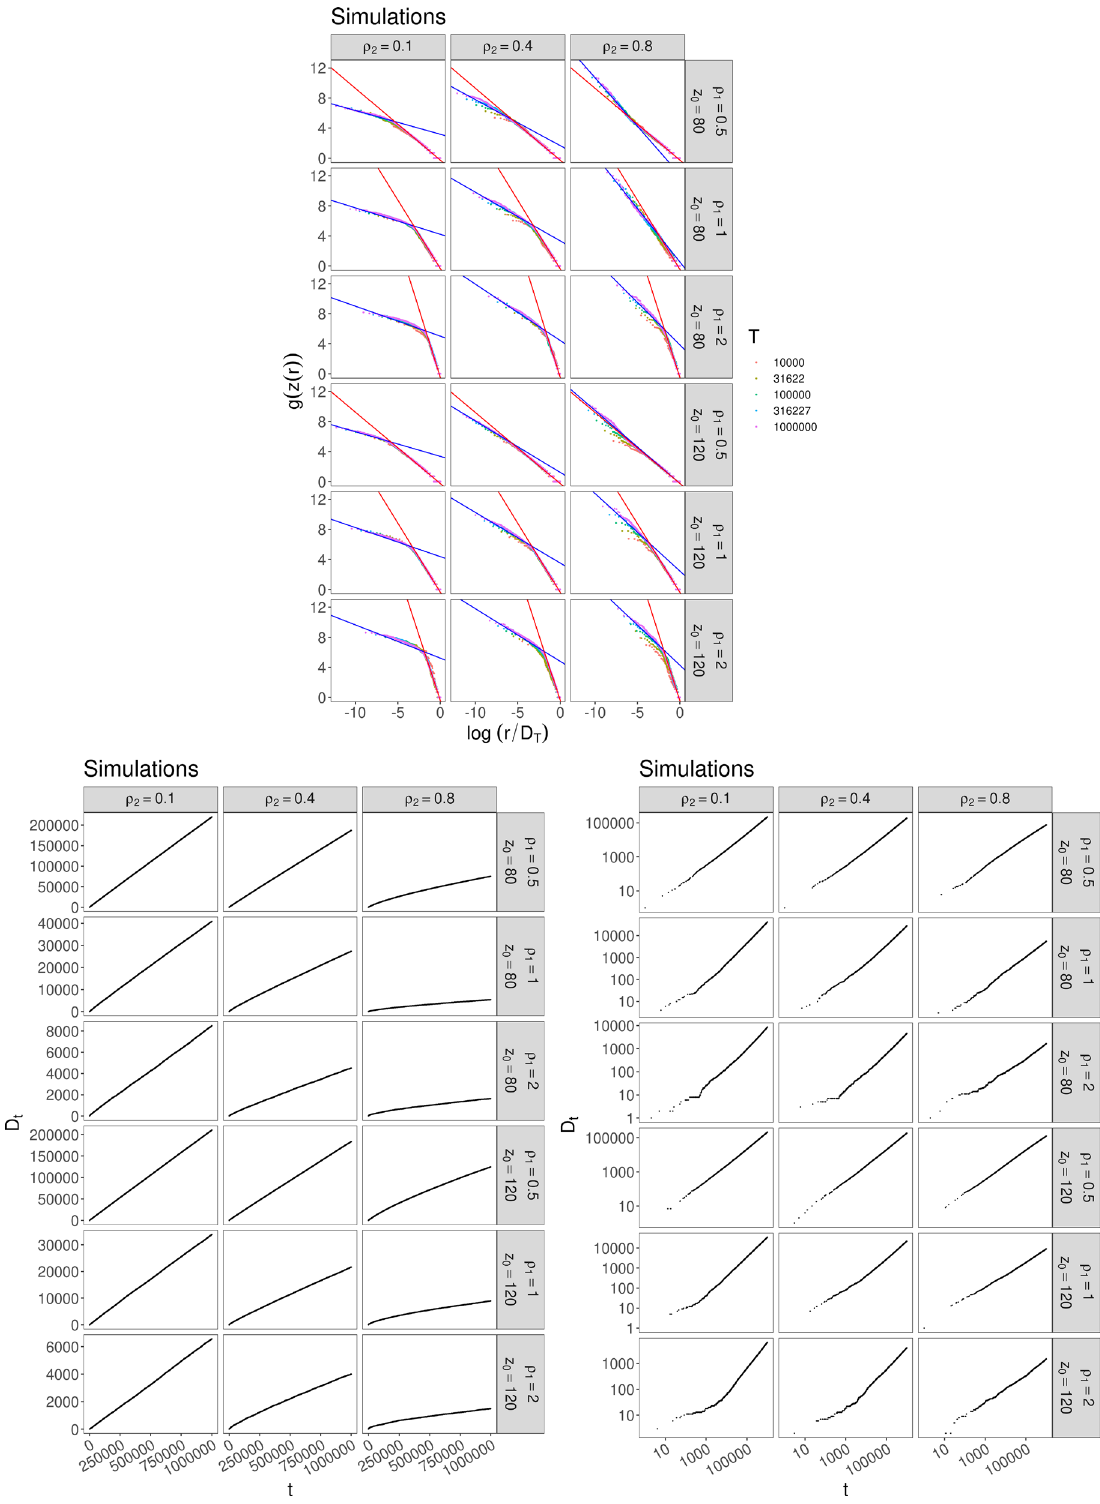
2 , ν 0.75 and different values of ρ 1 , ρ 2 and z z 0 : (Up) = = ∗ =